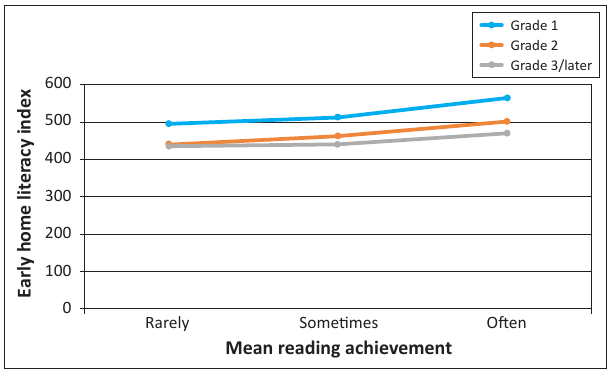
FIGURE 4: Effects of introducing the four neglected reading skills and strategies combined with parents conducting early home literacy